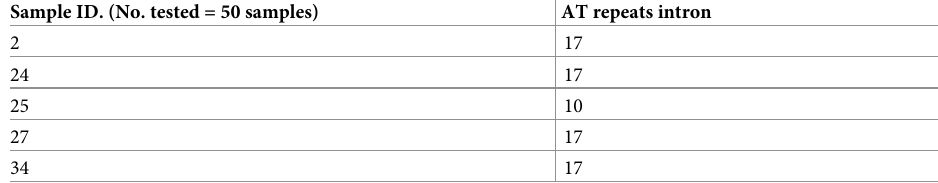
Table 4. Repeat sequences in pfhrp 2 intron, in 50 Ethiopian samples tested, those not listed did not give PCR products. Sample ID. (No. tested = 50